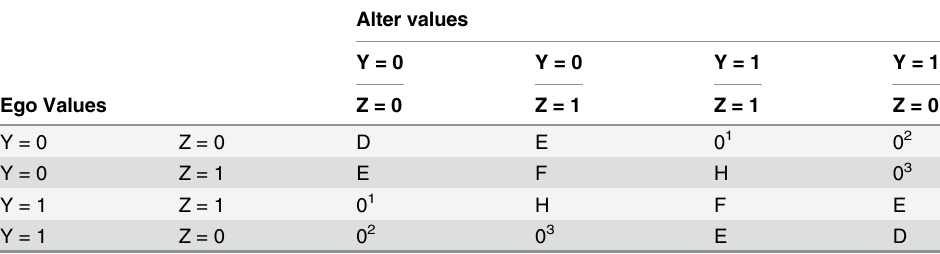
Table 1. Algebraic representations of friendships between Y|Z